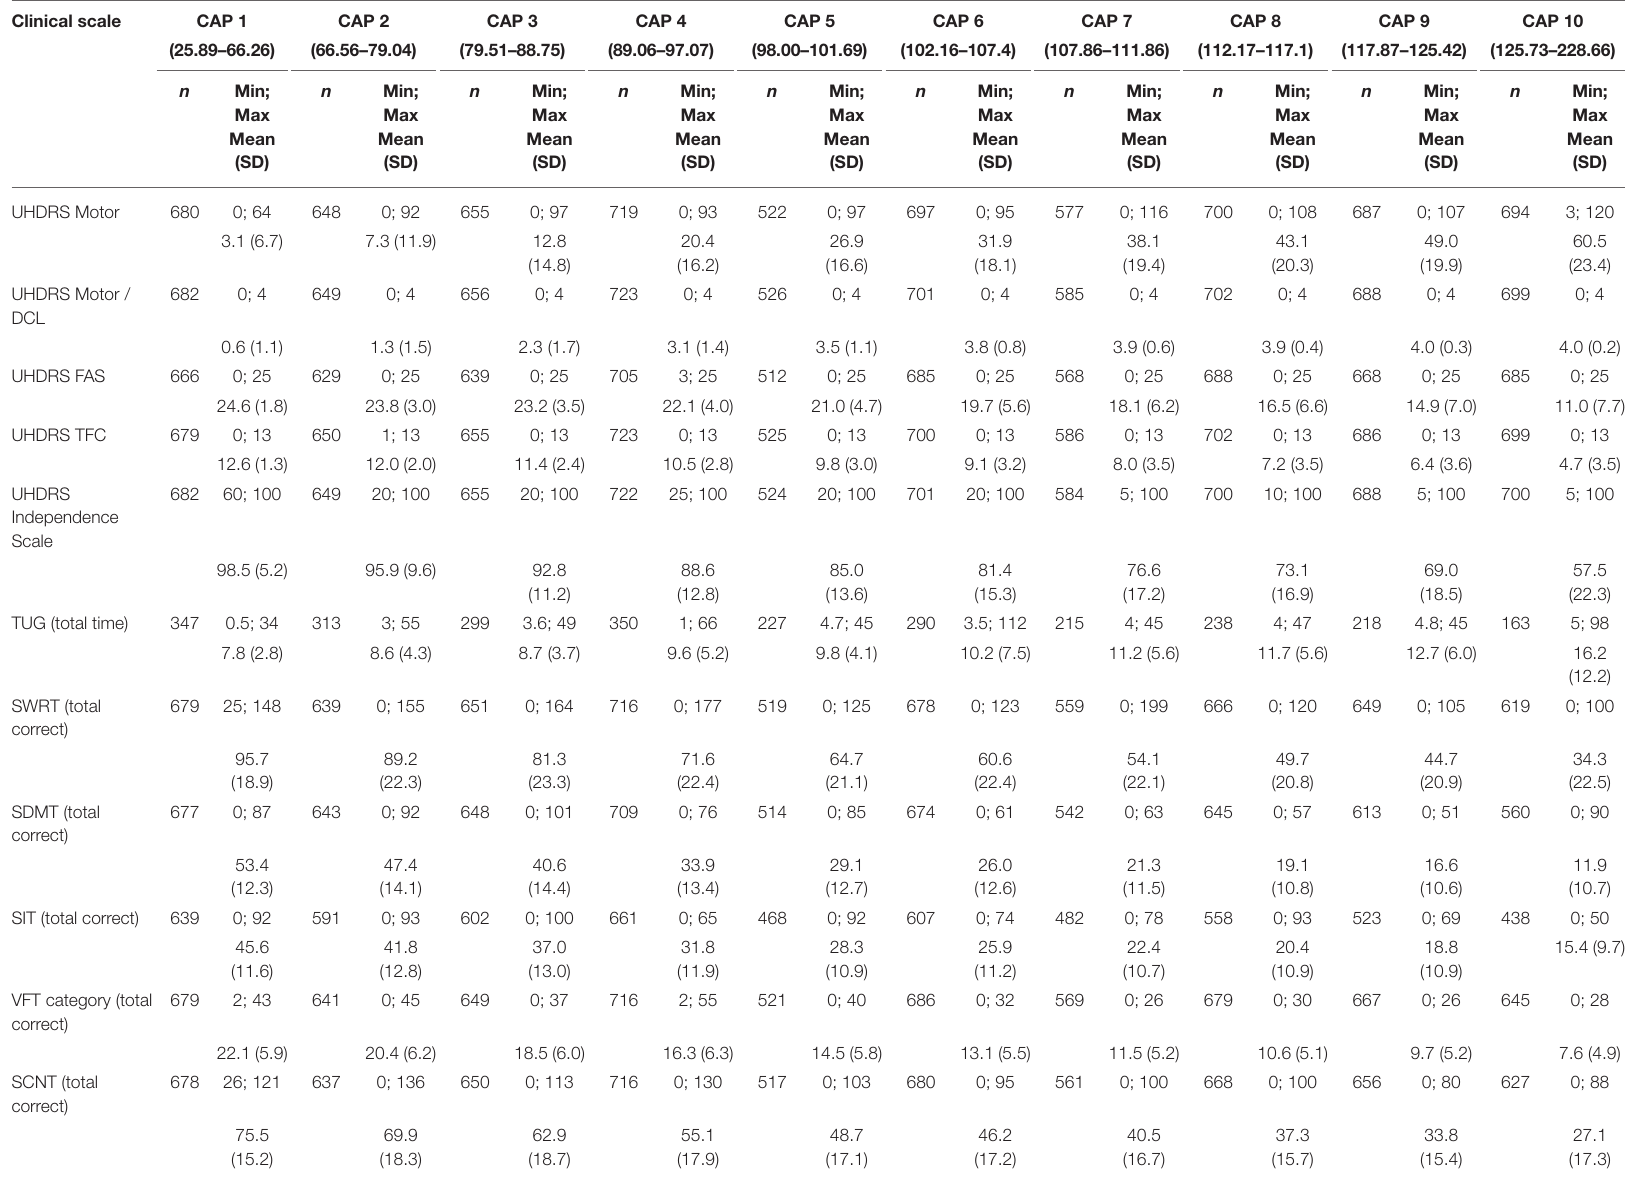
TABLE 3 | Clinical outcome measures by CAP score decile at baseline visit. Clinical